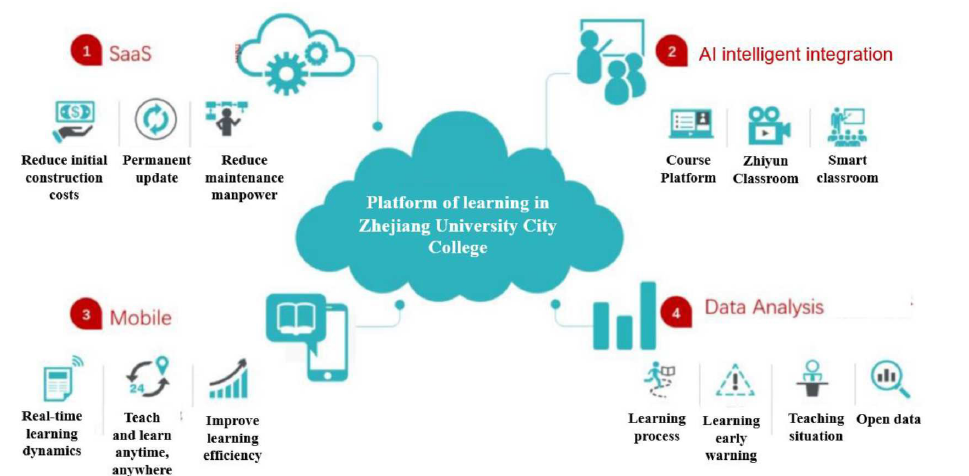
Fig. 1 Architecture of ‘Learning in Zhejiang University City